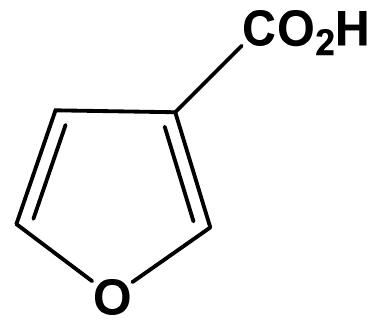
Chart 1. Structure of 3 ‐ furoic acid (3FurH).